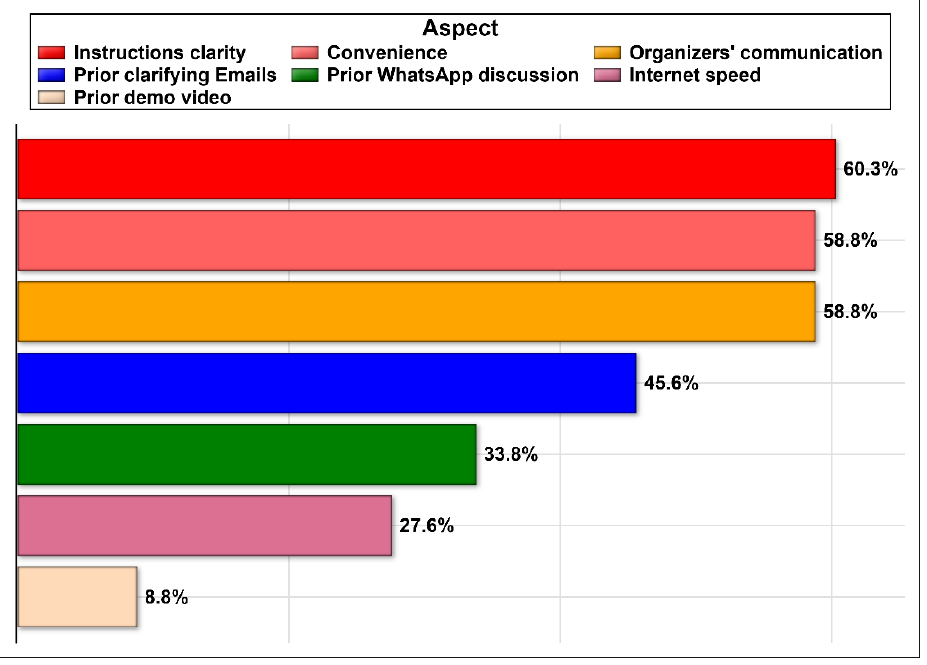
Figure 1. Different aspects of the OSCE experience that were viewed positively by the participants. Table 3. The e-OSCE teleconference participants perceived “Positive” versus “Negative” aspects about the experience.